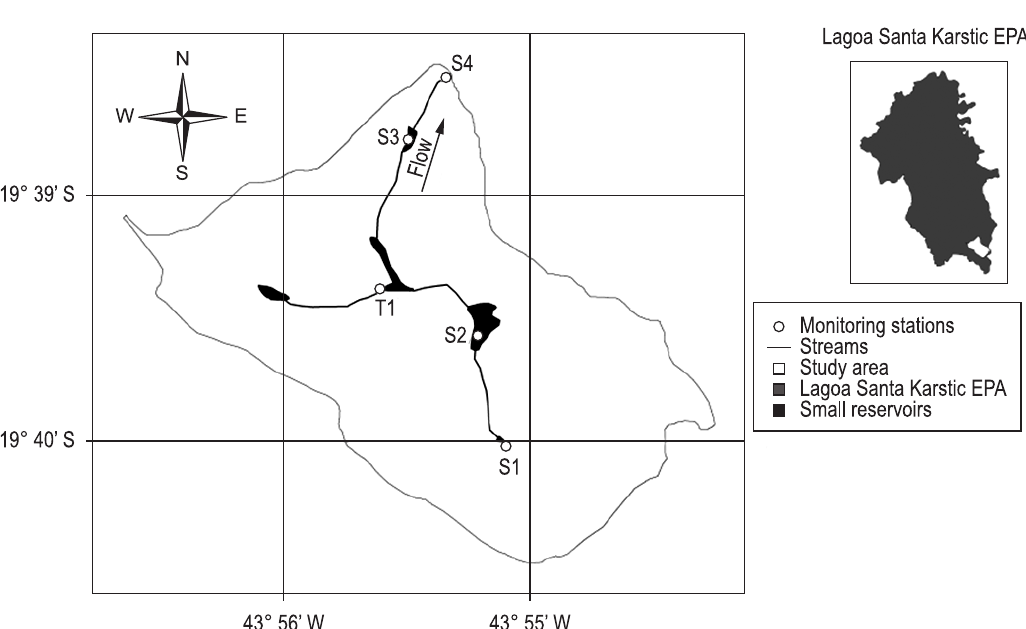
Figure 2. Location of the monitoring stations along the Fidalgo Stream and